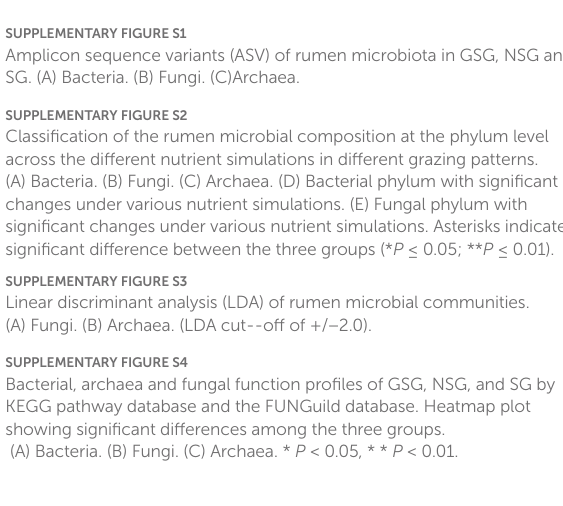
SUPPLEMENTARY FIGURE S4 Bacterial, archaea and fungal function profiles of GSG, NSG, and SG by KEGG pathway database and the FUNGuild database. Heatmap plot showing significant differences among the three groups. (A) Bacteria. (B) Fungi. (C) Archaea. * P < 0.05, * * P <